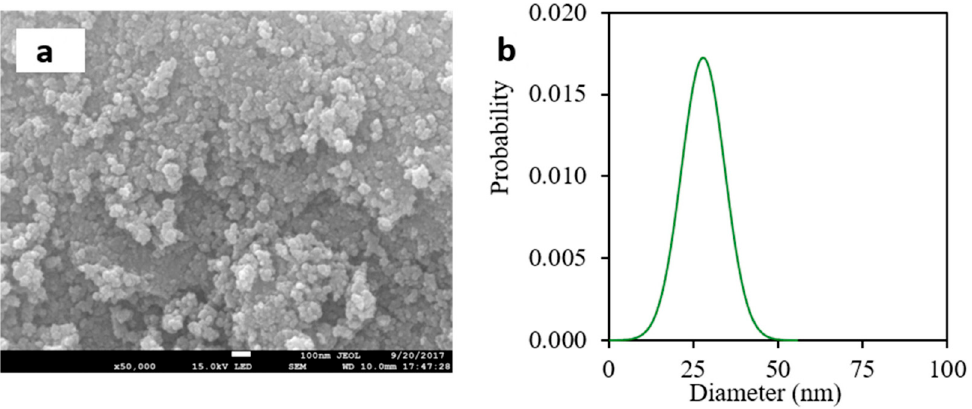
Figure 3. SEM micrograph ( a ) and the corresponding particle size probability distribution ( b ) for magnetite nanoparticles.